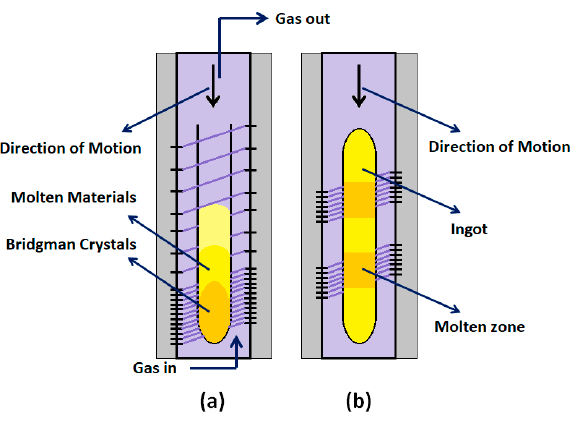
Figure 7. ( a ) Bridgman and ( b ) zone melting method utilized for organic single crystals growth.